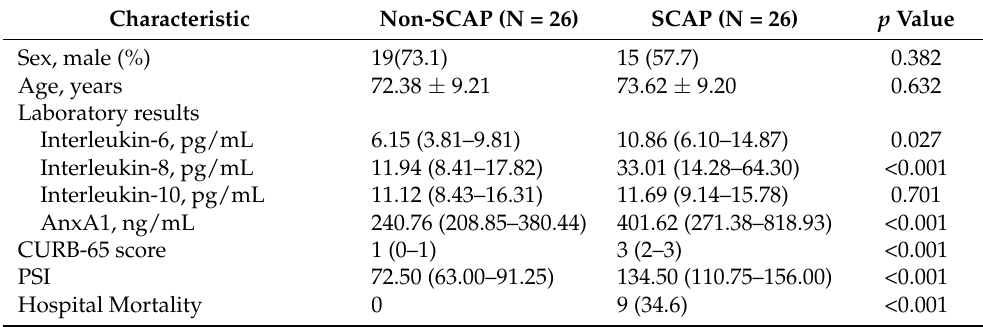
Table 2. Demographic and clinical characteristics of the CAP patients after matching.